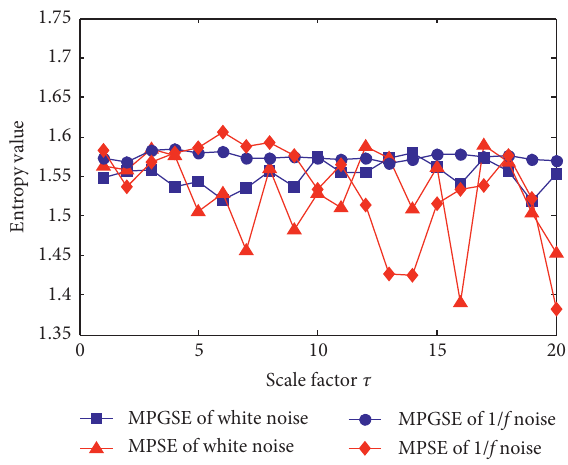
Figure 8: Two entropies’ analysis of white noise and 1/ f